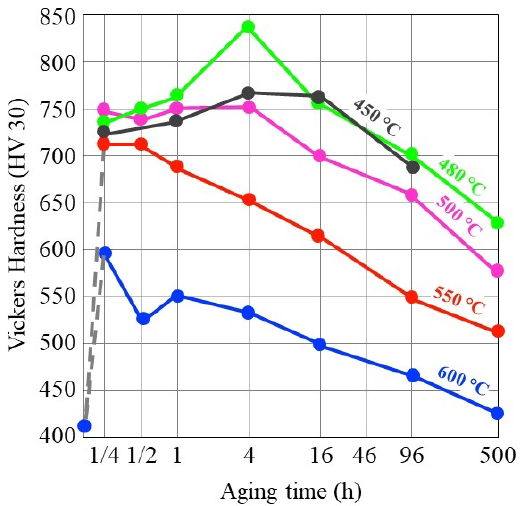
Figure 7. Vickers hardness variation as a function of aging time (in h.) for several temperatures for the Fe-13Ni-15Co-10.1 Mo-0.2Ti steel 40 .